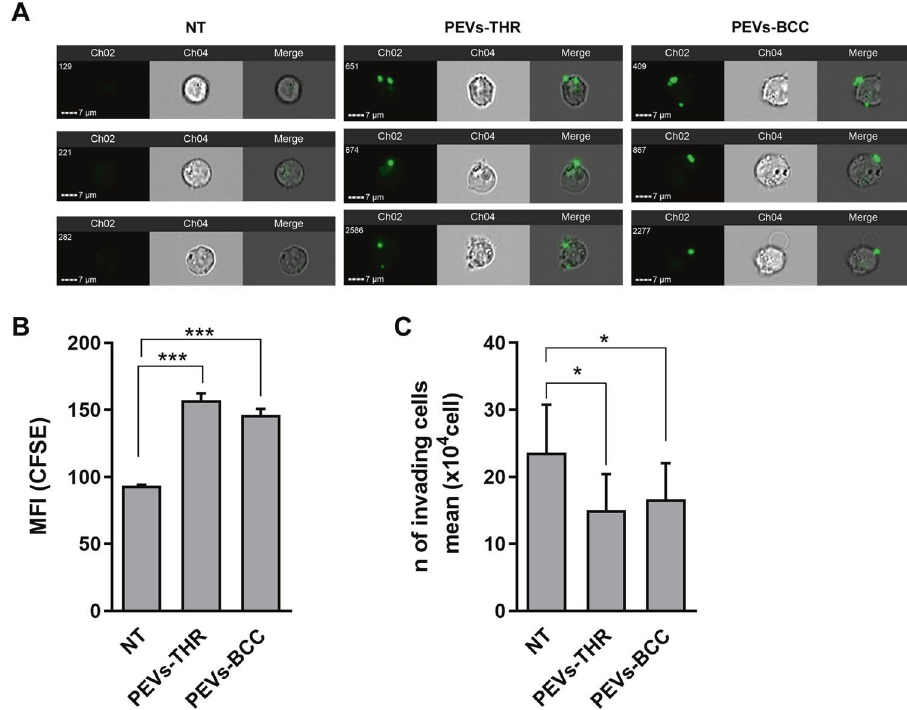
Fig. 5 Interaction of PEVs with Jurkat cells and analysis of cell invasion. A Representative images of CFSE-loaded PEVs interacting with Jurkat cells. For Jurkat cells treated with PEVs-THR or PEVs-BCC and untreated cells (NT), three representative examples including green- fl uorescence images of Channel 2 (Ch2), bright fi eld images of Channel 4 (Ch4) and Merge of Ch2 and Ch4 are shown. B Analysis of PEVs-Jurkat cells interaction by fl ow cytometry. Jurkat cells were co-cultured for 24 h with PEVs obtained from CFSE-labeled platelets upon stimulation with thrombin or MDA-MB-231 cells. The green- fl uorescent signal of PEVs associated to Jurkat cells was quanti fi ed as Median Fluorescence Intensity (MFI). The plot reports the mean ± SD of three independent experiments. *** p < 0.0001 (sample vs NT). C Jurkat cells migration evaluated by transwell assay. Cells that moved in the bottom chamber were collected and counted using a hemocytometer. The data are expressed as number of migrated cells and the graph shown the mean ± SD of four independent experiments with * p <